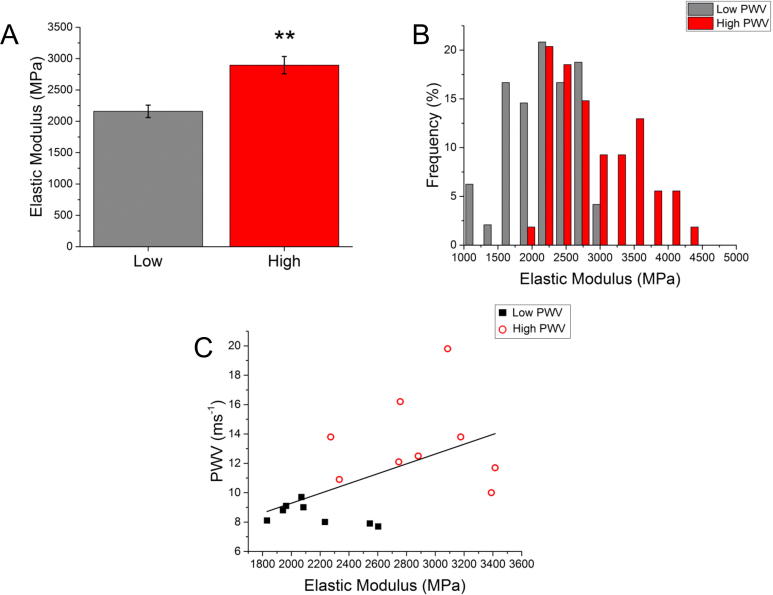
Nanomechanical properties of the adventitia for the low and high PWV group. (A) Bar graph showing mean ± SEM (n = 8 and n = 9 patients in the low and high group). Asterisks represent a significance difference between both groups with p-value < 0.01 (B) Elastic modulus distribution in each group (n = 48 and 54 measurements in the low and high PWV groups Kolmogorov-Smirnov, p < 0.001). (C) A positive correlation of 0.56 between PWV and elastic modulus was found when data from both groups was pooled together (Spearman’s Rank Order Correlation, p-value = 0.02).